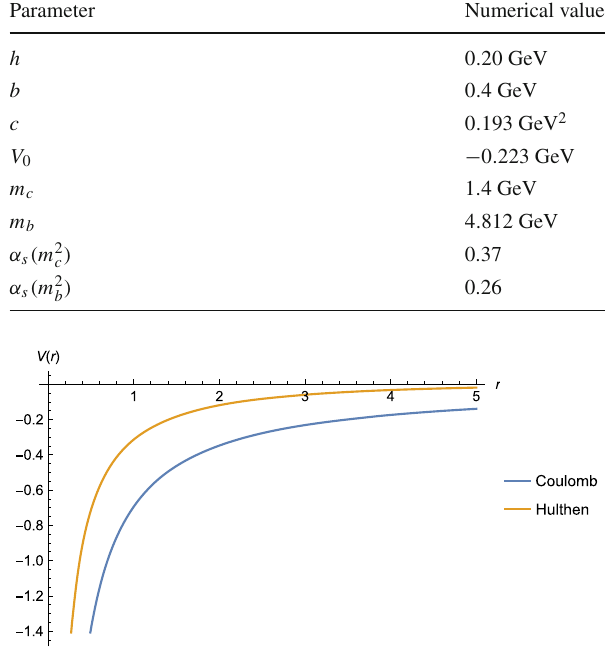
Fig. 1 Comparison of Coulomb potential and Hulthen potential for large r . V ( r ) is in GeV and r in fm units